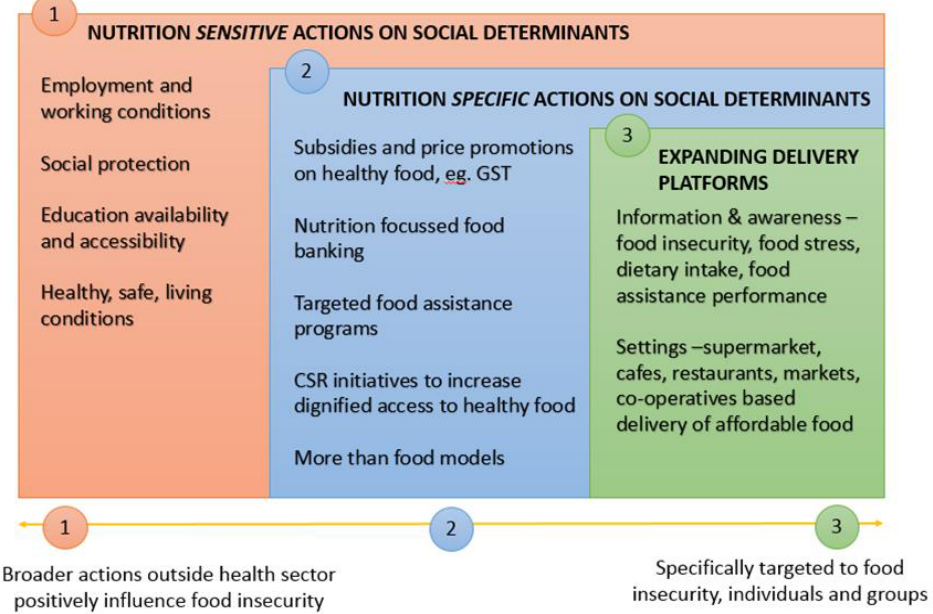
Figure 1. Typology of multi-sectoral actions on food and nutrition security (Adapted from Figure 8 p. 45 Discussion Paper Addressing the Social Determinants of Non-communicable Diseases [52]).